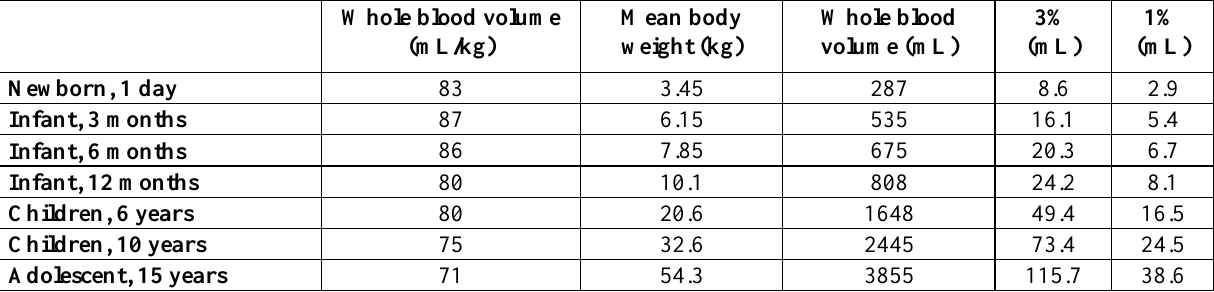
Table 7. Age ranges and corresponding volume limits for blood sampling